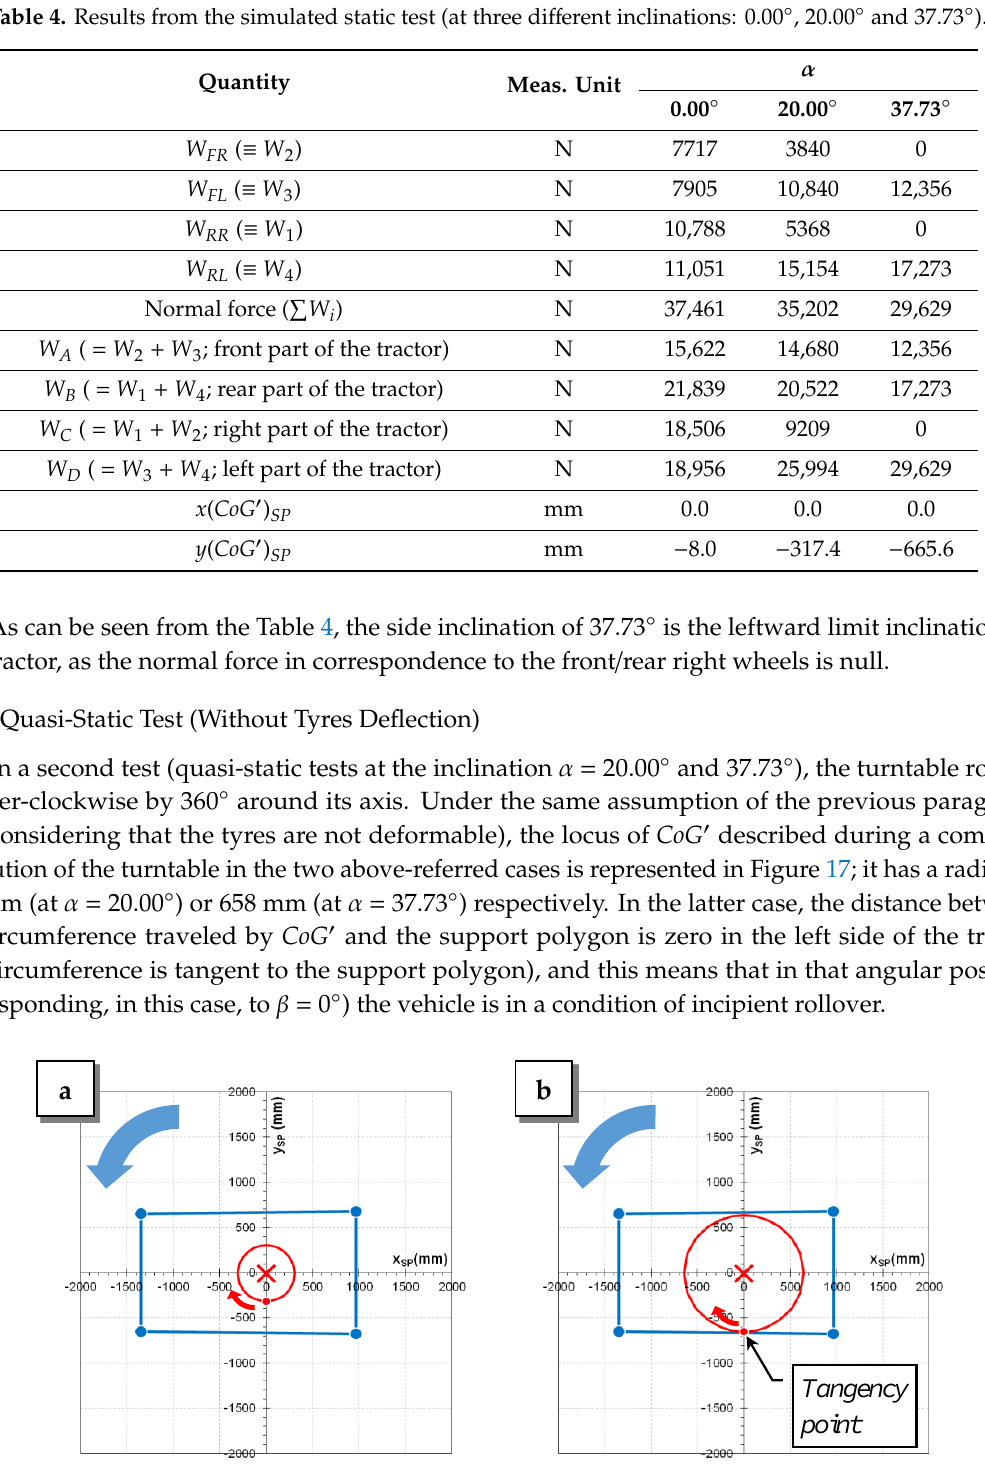
Figure 17. Locus of the positions of CoG′ in the frame of reference fixed to the turntable, when the turntable does a complete counter-clockwise rotation around its rotation axis (i.e., the origin of the reference frame) for ( a ) α = 20.00 ◦ and ( b ) α = 37.73 ◦ . The blue arrow indicates the direction of